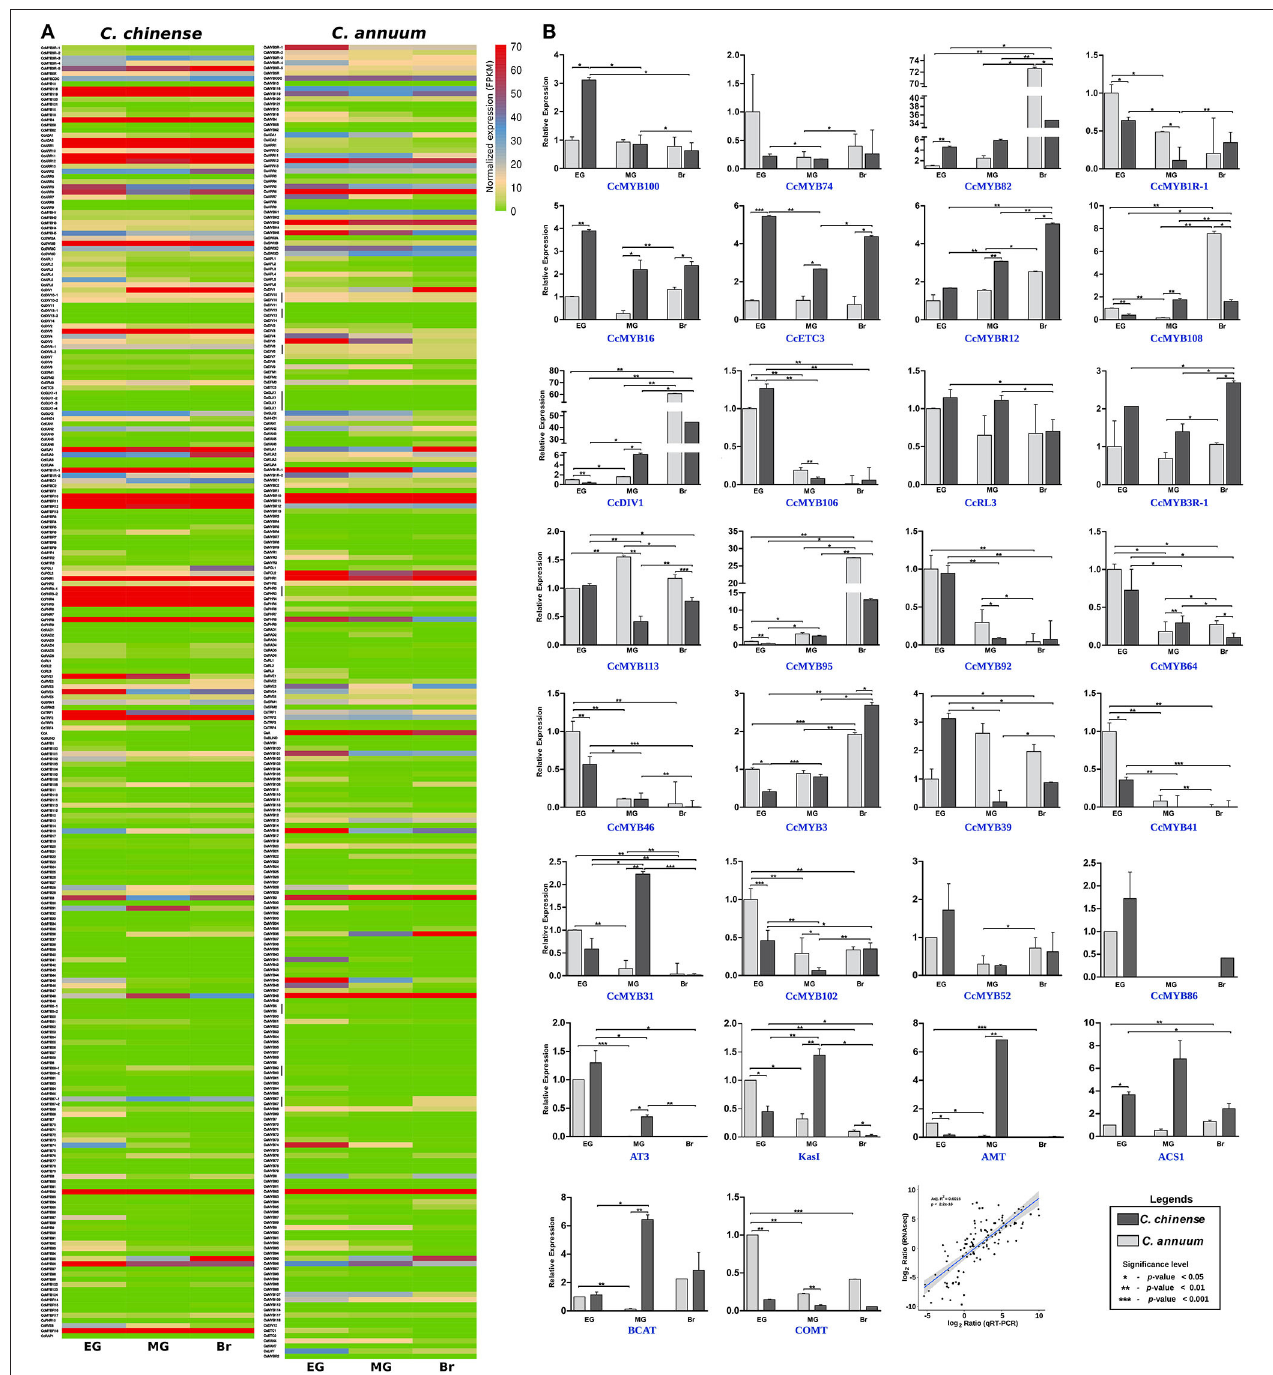
FIGURE 7 | Ribonucleic acid sequencing (RNAseq) and quantitative real-time (qRT)-PCR expression data of Capsicum MYBs at the early green (EG), mature green (MG), and breaker (Br) fruit development stages. (A) Normalized FPKM expression of C. chinense MYBs and their C. annuum homologs by RNAseq, and (B) relative expression of 24 CcMYB genes and capsaicinoid biosynthesis pathway genes ( AT3 , KasI , pAMT , ACS1 , BCAT, and COMT ) between C. chinense (Bhut Jolokia; Acc-Cc74) and C. annuum (Acc-Ca18) by qRT-PCR in the three fruit developmental stages and correlation between RNAseq and qRT-PCR expression data. A Student t -test was performed to calculate the significant difference of expression. The significance level was represented as *** p < 0.001; ** p < 0.01, and * p < 0.05).